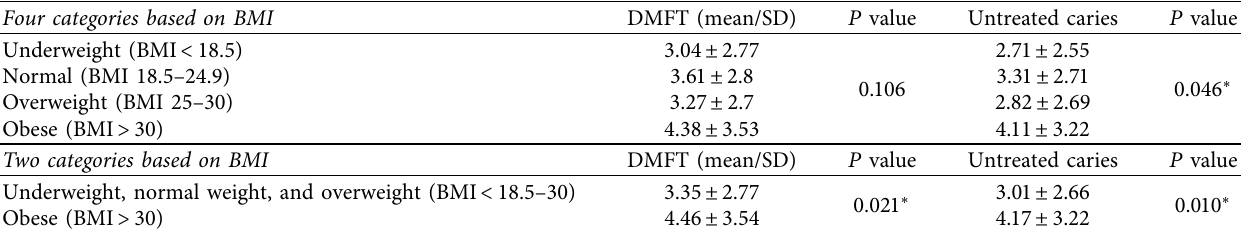
Table 2: Relationship between BMI and dental caries experience among study